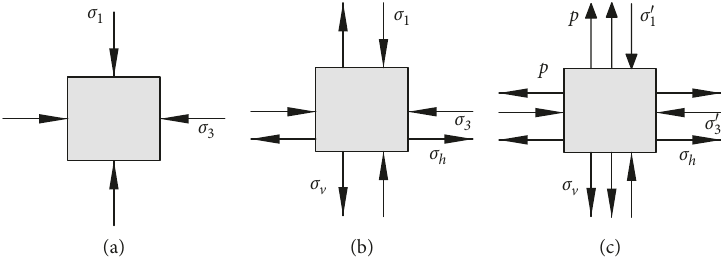
Figure 1: Stress state of soil. (a) Total stress state. (b) Single water seepage. (c) Double action of water seepage and earthquake.